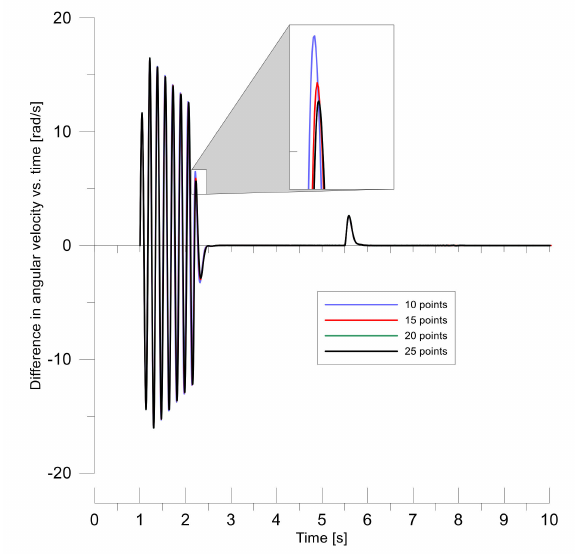
Figure 5. Di ff erence in angular velocity vs.